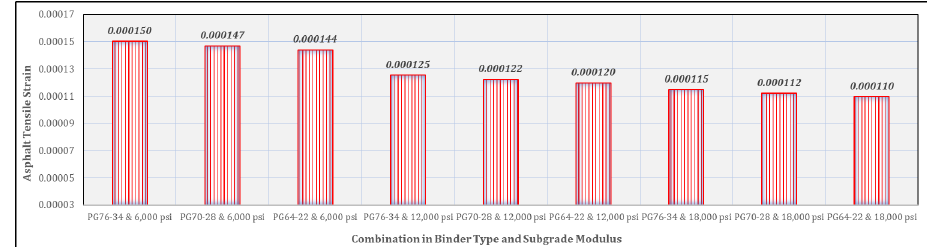
Figure 35: Influence of subgrade modulus and binder type on asphalt tensile strain in asphaltic overlayment rail